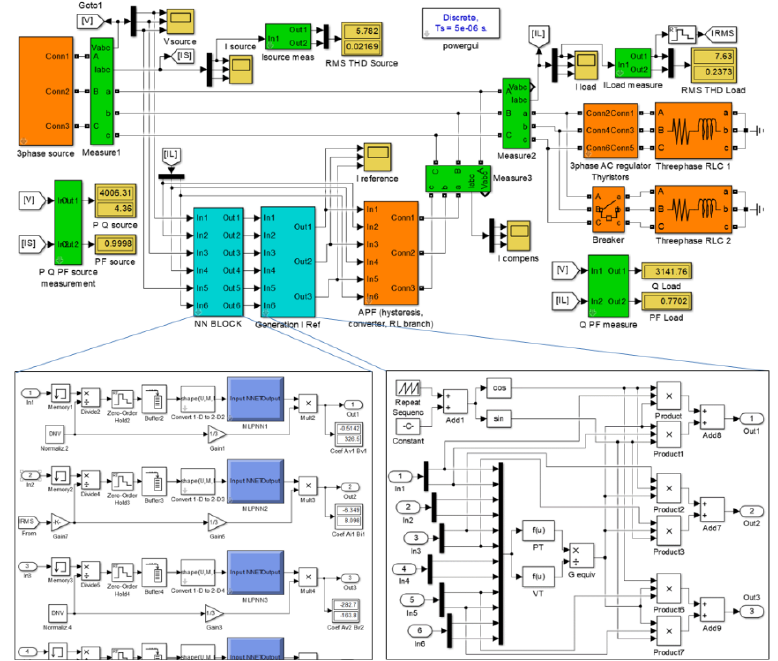
Figure 9. MATLAB-Simulink model in the practical case of UpfC control with a change in connection of a linear load in parallel with the nonlinear one. It shows details inside the NN Block (for clarity, only a part of the 6-ANN content), and details inside the “Generation I ref” subsystem with the computations for generating the waveforms by using the 12